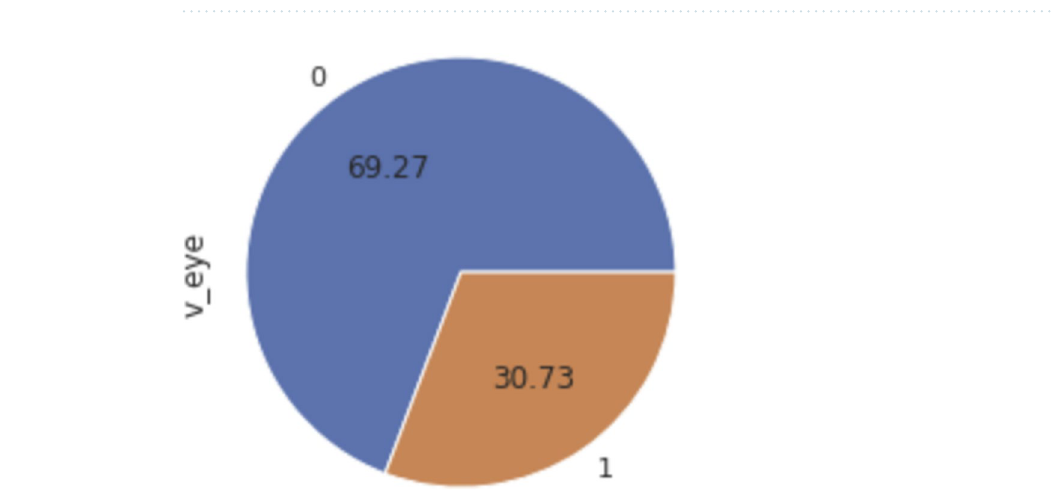
Figure 8. A sample of the observation features included in our dataset.